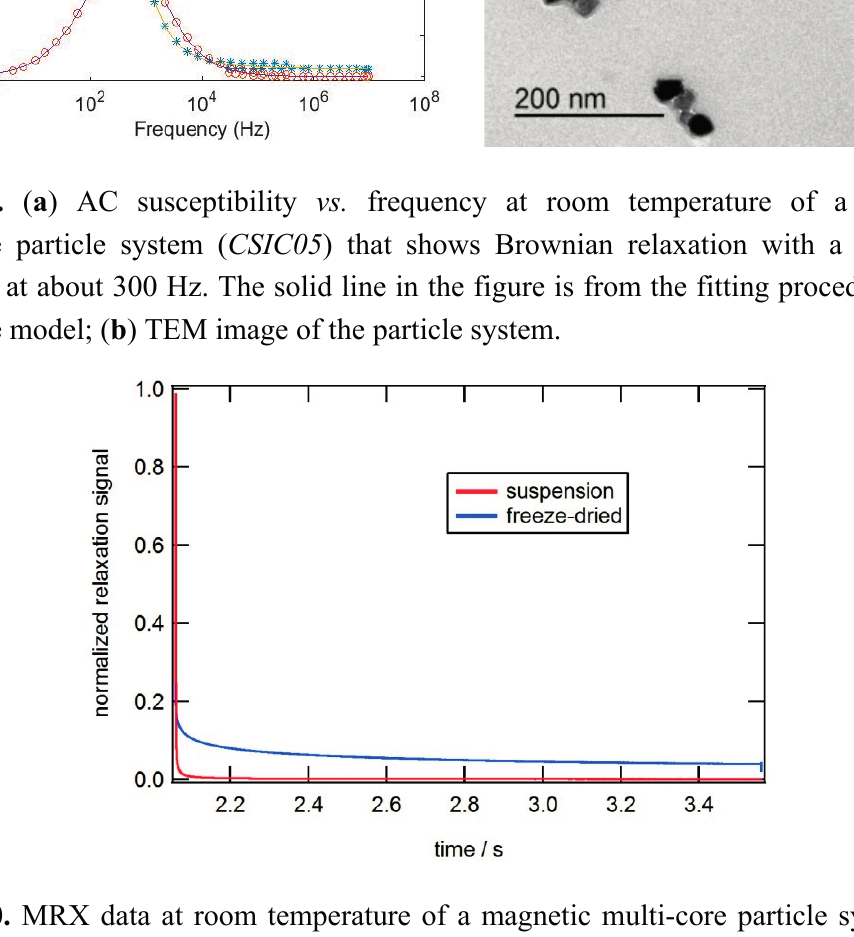
Figure 10. MRX data at room temperature of a magnetic multi-core particle system ( CSIC05 ) that shows Brownian relaxation when particles are suspended in liquid (in red), and long Néel relaxation when the particles are immobilized (in